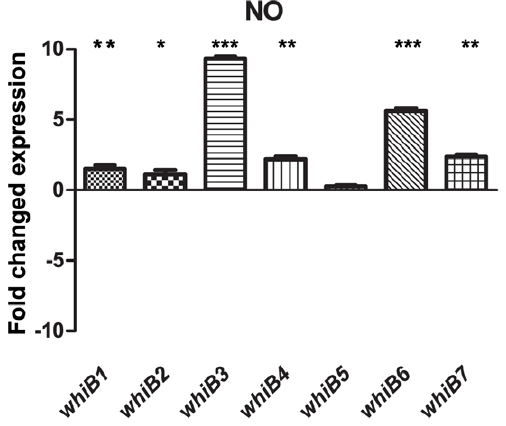
Figure 4. Effect of db-cAMP on whiB1-7 expression. M.tb CDC1551 was grown 24h in the presence of 500 m M db-cAMP. whiB1 and to a lesser extent 2 2 and 2 4 were up-regulated.